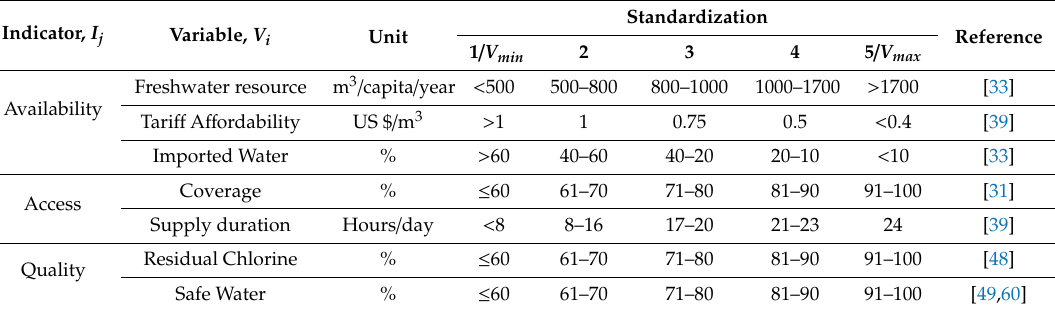
Table 2. Benchmarking variables for water supply dimension.